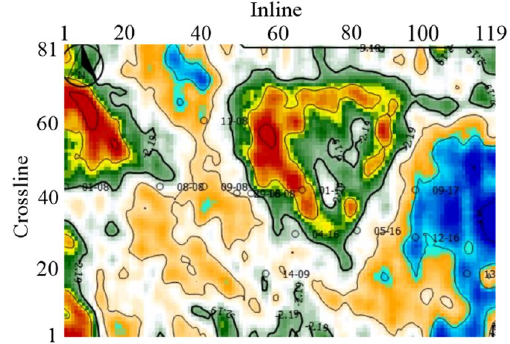
Fig. 2 Location of wells in the study